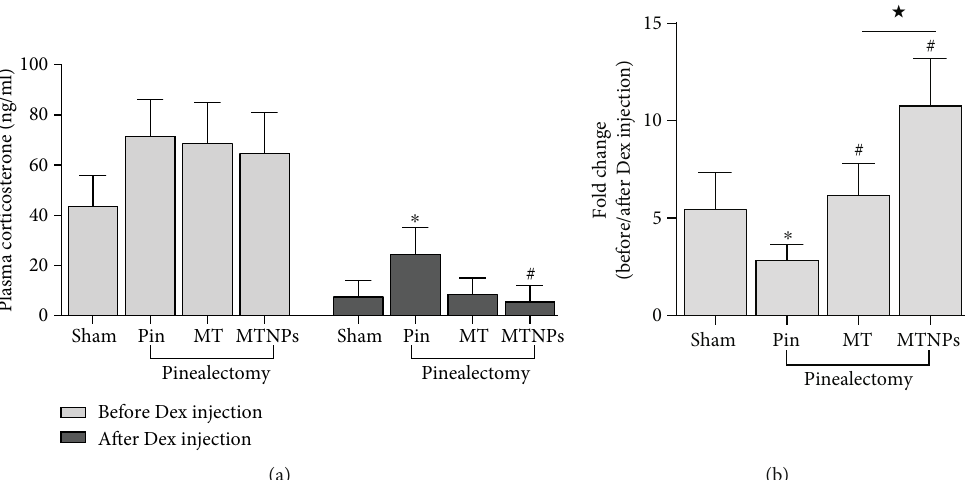
Figure 8: E ff ect of melatonin-loaded nanoparticles (MTNPs) on the plasma corticosterone level. (A) The plasma corticosterone level. (b) The decreased fold change of plasma corticosterone. ∗ P < 0 : 05 vs. the sham group; # P < 0 : 05 vs. the Pin group; ★ P < 0 : 05 vs. the MT group. Pin: pinealectomized rats; MT: